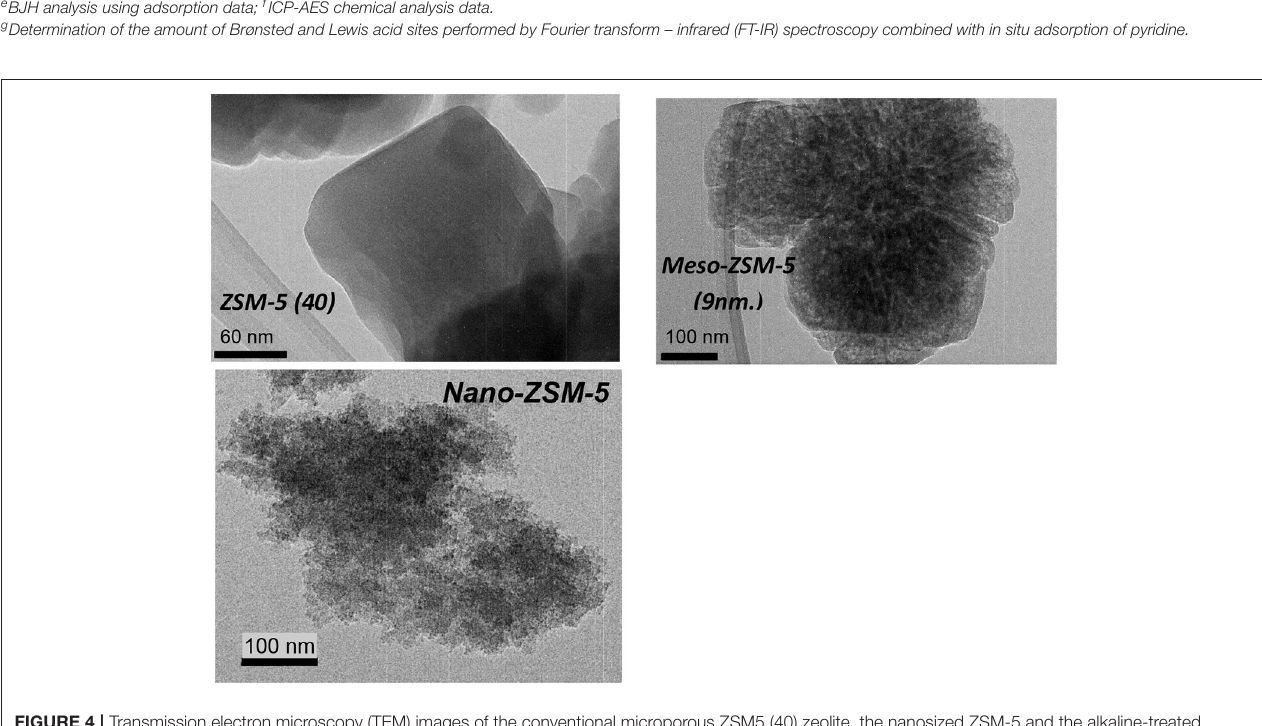
TABLE 2 | Porosity, chemical composition and acidity data of the various ZSM-5 zeolite catalysts. Catalyst BET area a Micro- pore Meso/ macro pore & Average mesopore Chemical composition f Acidity g (m 2 /g) area b (m 2 /g) external area c (m 2 /g) diameter e (nm) Al Na FT-IR/pyridine ( µ mol Pyr/g) (wt.%) Brønsted Lewis B/L ZSM-5(11.5) 424 349 75 – – Meso-ZSM-5 (9nm) 560 259